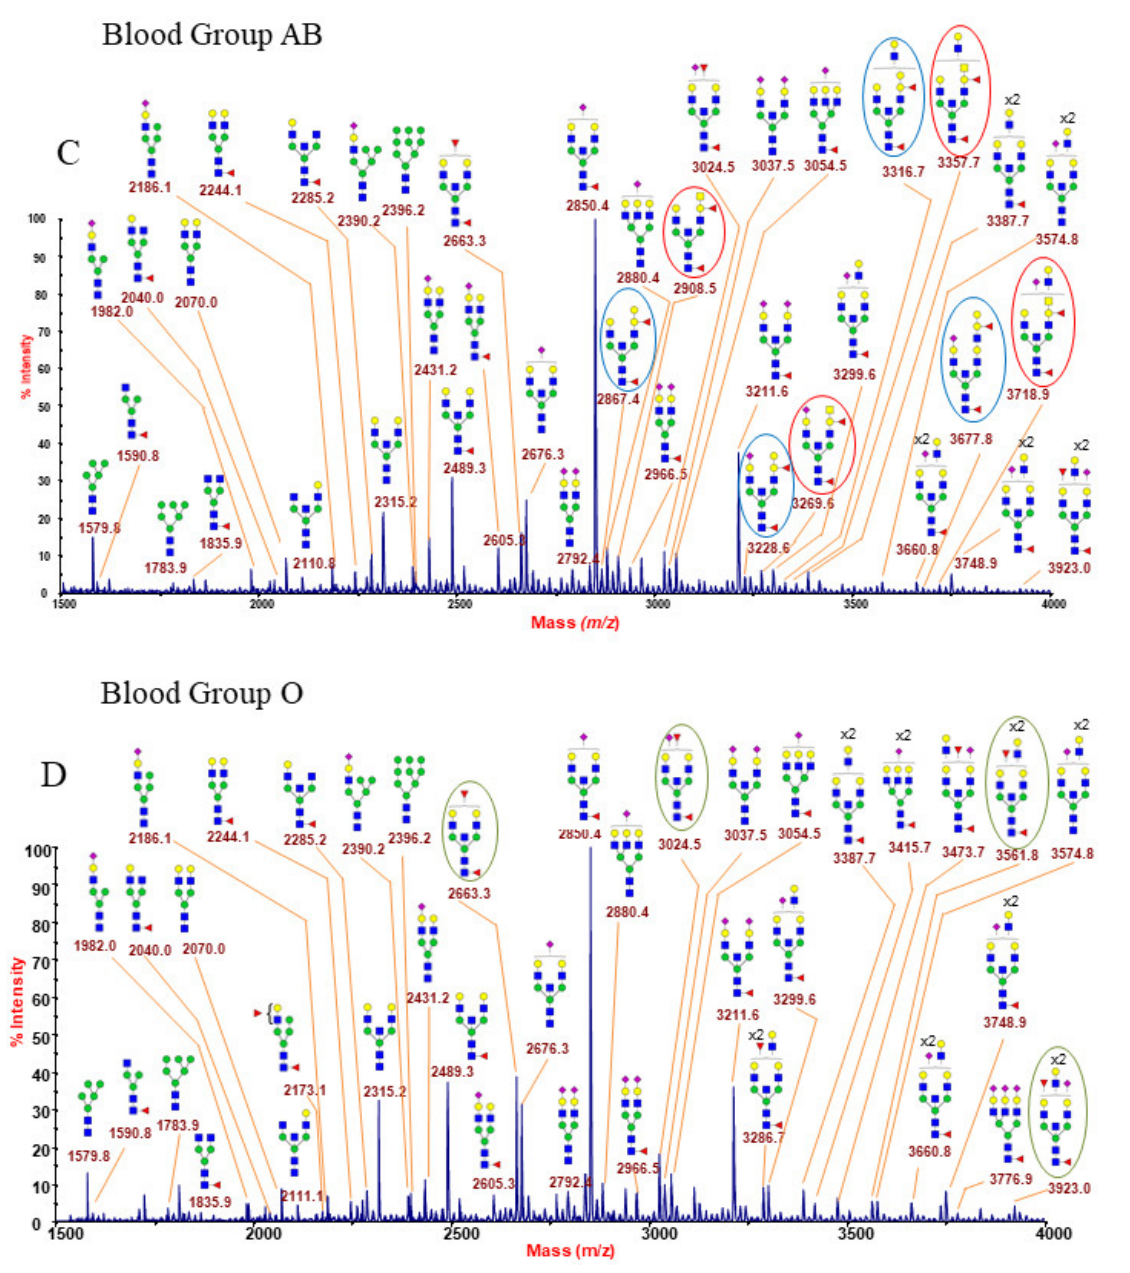
Figure 1. ( A , B ). MALDI-TOF mass spectra at low mass-range (m/z 1500–4000) showing molecular ions [M + Na] + of permethylated N-linked glycans from human erythrocyte blood groups A and B. MALDI-TOF MS mapping of permethylated N-glycans from RBC is distinctive of each blood group. ( A ) Blood group A; ( B ) blood group B. Structures consistent with glycoforms comprising blood group A and blood group B epitopes are highlighted with red and blue circles, respectively. N-acetylglucosamine (GlcNAc), blue square; Mannose (Man), green circle; Galactose (Gal), yellow circle; Sialic acid (NeuAc), purple lozenge; Fucose (Fuc), red triangle. ( C , D ). MALDI-TOF mass spectra at low mass-range (m/z 1500–4000) showing molecular ions [M + Na] + of permethylated N-linked glycans from human erythrocyte blood groups AB and O. MALDI-TOF MS mapping of permethylated N-glycans from RBC is distinctive of each blood group. ( C ) Blood group AB; ( D ) blood group O. Structures consistent with glycoforms comprising blood group A, blood group B, and blood group O epitopes are highlighted with red, blue, and green circles, respectively. N-acetylglucosamine (GlcNAc), blue square; Mannose (Man), green circle; Galactose (Gal), yellow circle; Sialic acid (NeuAc), purple lozenge; Fucose (Fuc), red triangle.